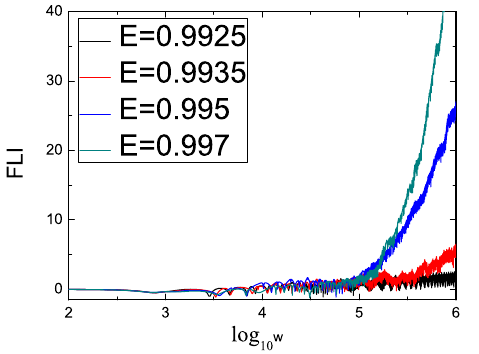
Figure 10. Fast Lyapunov indicators (FLIs). The parameters are L = 4.6, a = 0.5, B ∗ = 0.001, and Q ∗ = 0.001. The initial separation is r =